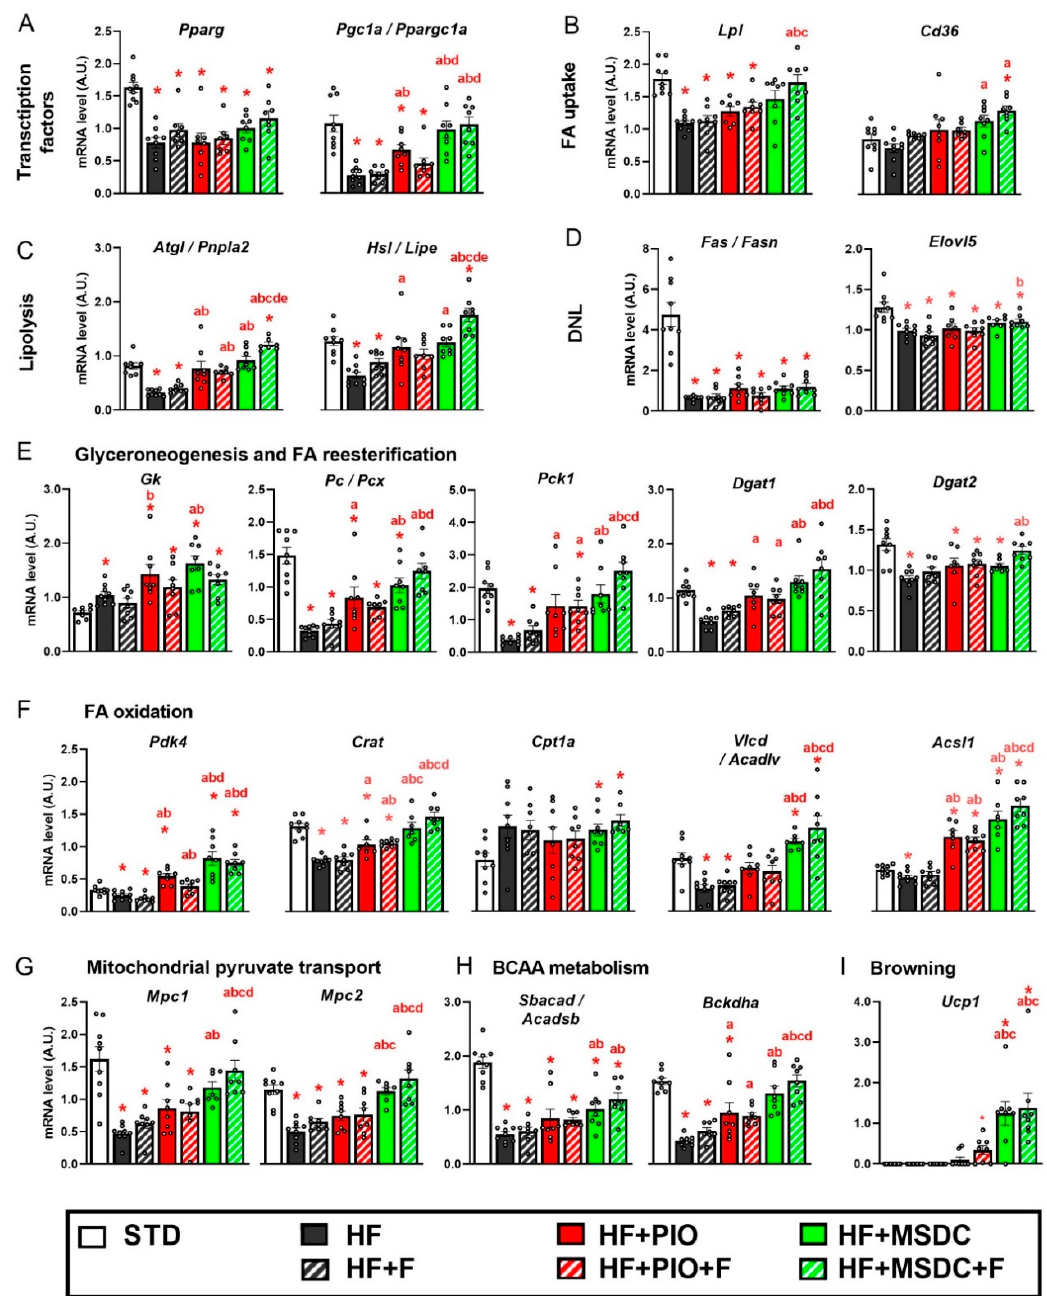
Figure 8. Expression of selected genes in eWAT. Mice were fed STD or various HF diets for 8 weeks. Expressions of the genes engaged in various regulatory and metabolic pathways ( A – I ) were evaluated using RT-qPCR and normalized to the mean signal of four reference genes (see Materials and Methods). Data are means ± SEMs ( n = 8). * Significantly different from STD ( p ≤ 0.05, t -test). a—significantly different vs. HF; b—significantly different vs. HF + F; c—significantly different vs. HF + PIO; d—significantly different vs. HF + PIO + F; e—significantly different vs. HF + MSDC ( p ≤ 0.05, one-way ANOVA. For designation of dietary groups, see Section 2.1.